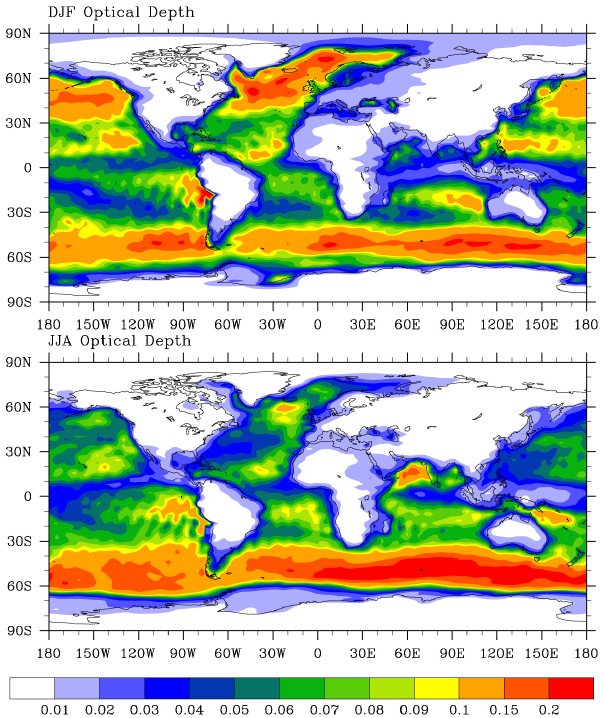
Fig. 20. Modeled global distribution of SSA surface number con- centration in the boreal winter (DJF, December, January, and Febru- ary) and summer (JJA, June, July, and August) of 2006. The model used the CMS source function and a solubility factor of